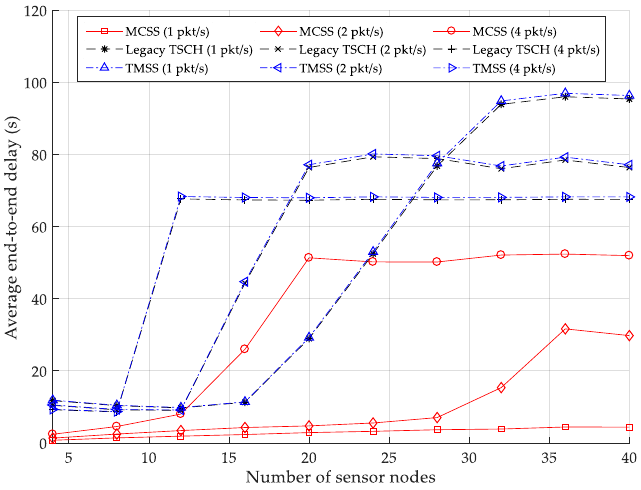
Figure 7. Average end-to-end